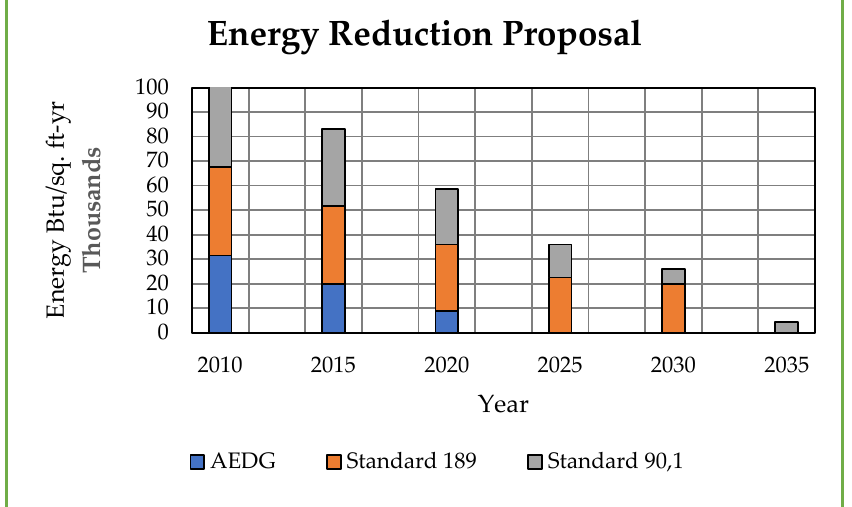
Figure 5. Energy Reduction Proposals: ASHRAE 90,1 and 189 [44].